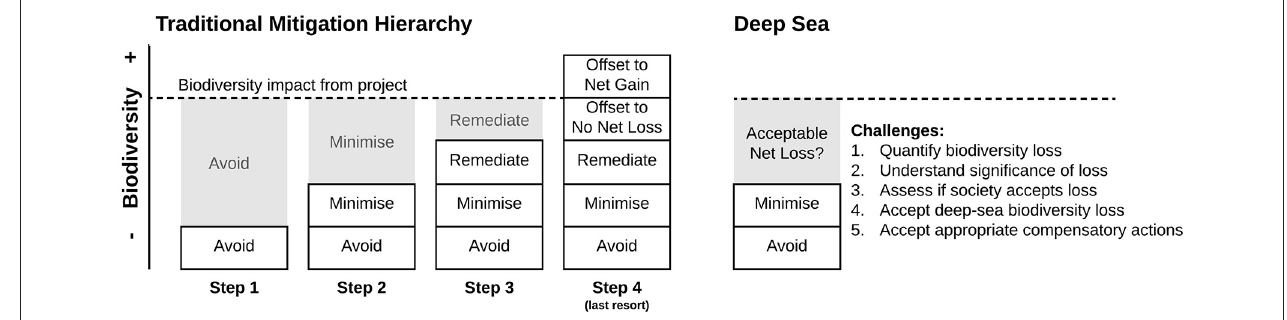
FIGURE 1 | The mitigation hierarchy as applied in its intended sequence and the challenges posed by deep sea